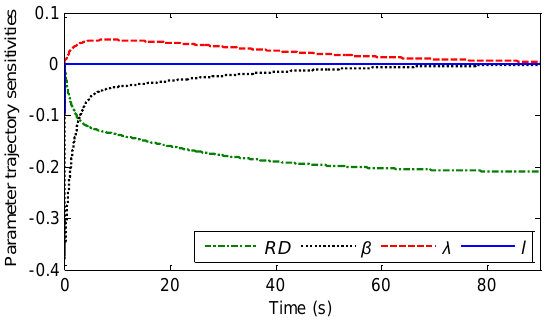
Figure 14. Sensitivity analysis of parameter change with one-loop temperature feedback.